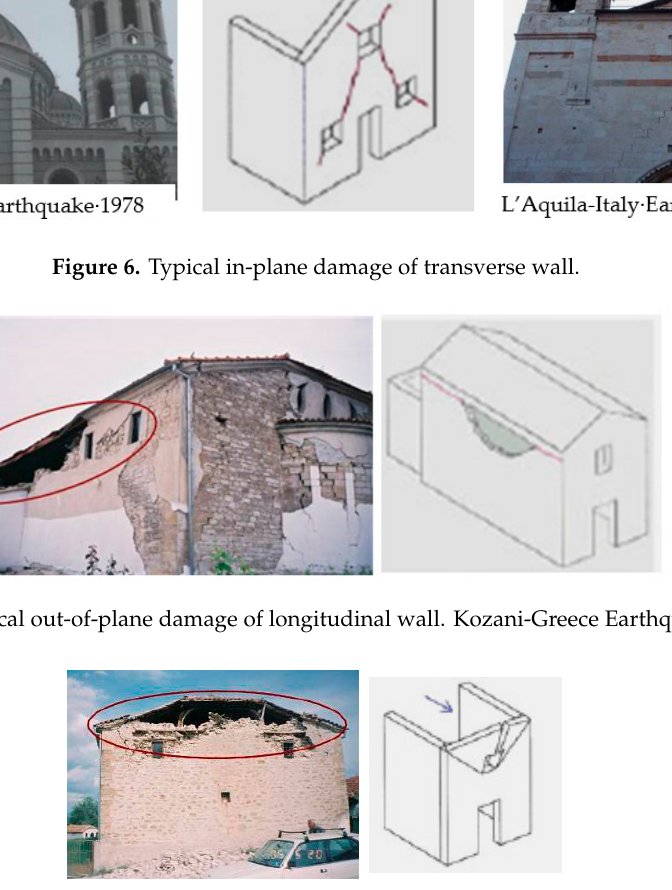
Figure 8. Typical out-of-plane damage of longitudinal wall. Kozani-Greece Earthquake 1995.